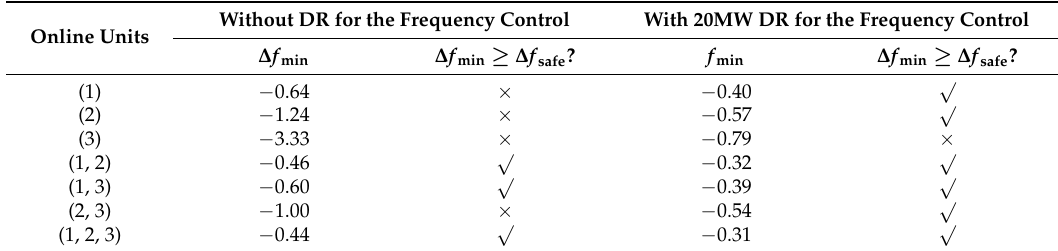
Figure 5. The system frequency responses for different combinations of online generation units. ( a ) Without DR; ( b ) With 20MW DR for the frequency control. Table 1. ∆ f min for different combinations of online generators.